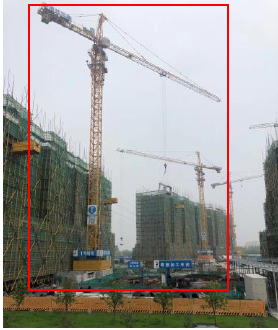
Figure 1. Upper slewing tower crane (Image by Qiang Li).